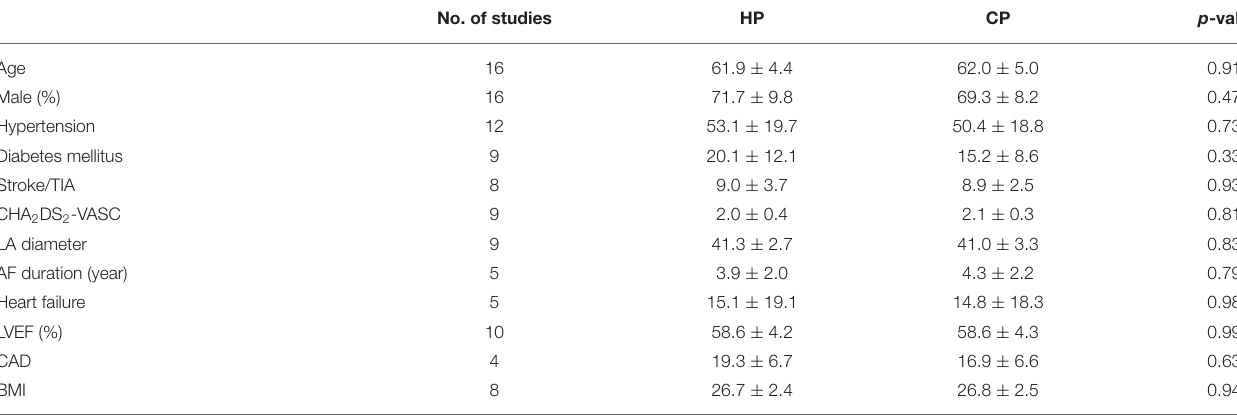
TABLE 3 | Baseline population demographics of included